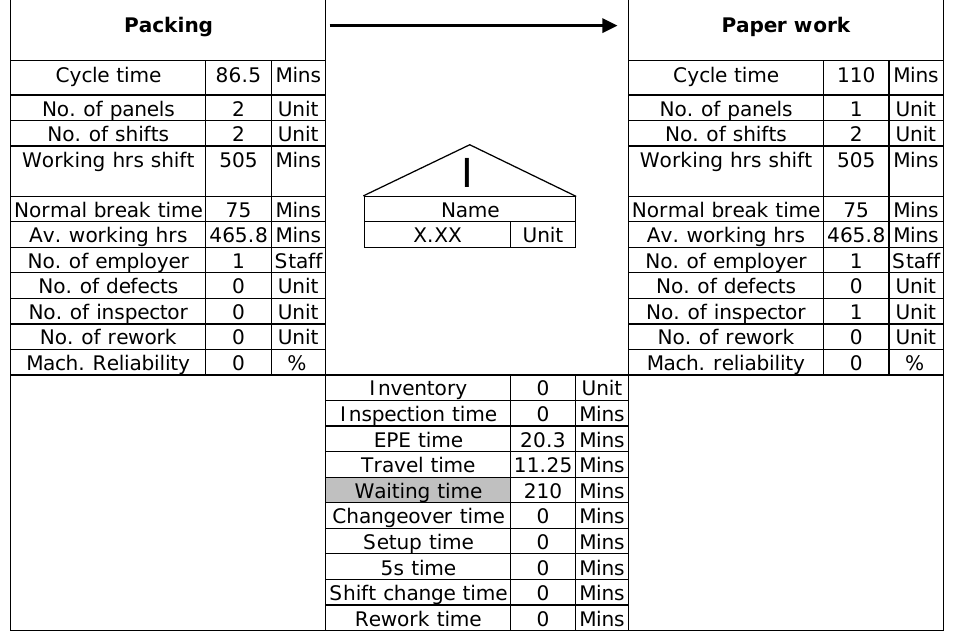
Figure 5. “Travel time wastages (packing to